Question: Author a descriptive caption for the visualization shown.
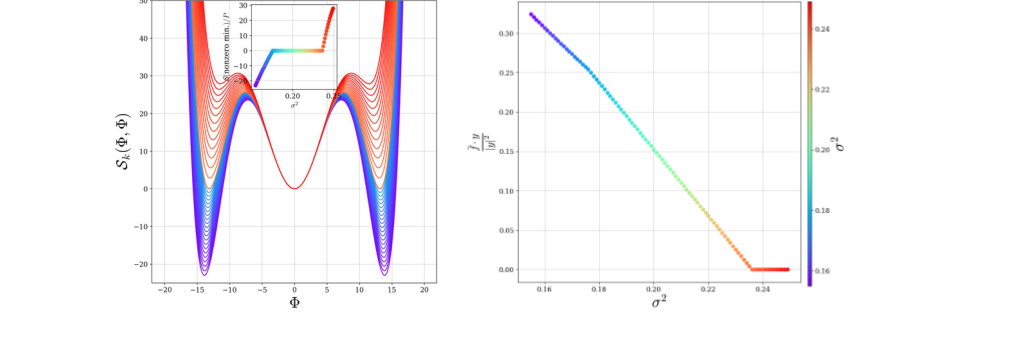
Answer: GFL to GMFL-I to GMFL-II (a) Probability distribution of weights as predicted by our approach. The GFL phase is represented by the red graphs, where the minimum of the action at zero (shared also by the GP limit) dominates the probability distribution. The GMFL-I phase can be seen in the inset graph, and the final GMFL-II phase is shown in purple.(b) The target component of the average network output. Here singularities can be observed at the σ2 values where the phase transi- tions occur. The Parameters taken in this calculation are: N = 1000, P = 401, σ2 a = 0.002/N, γ = 0.0001